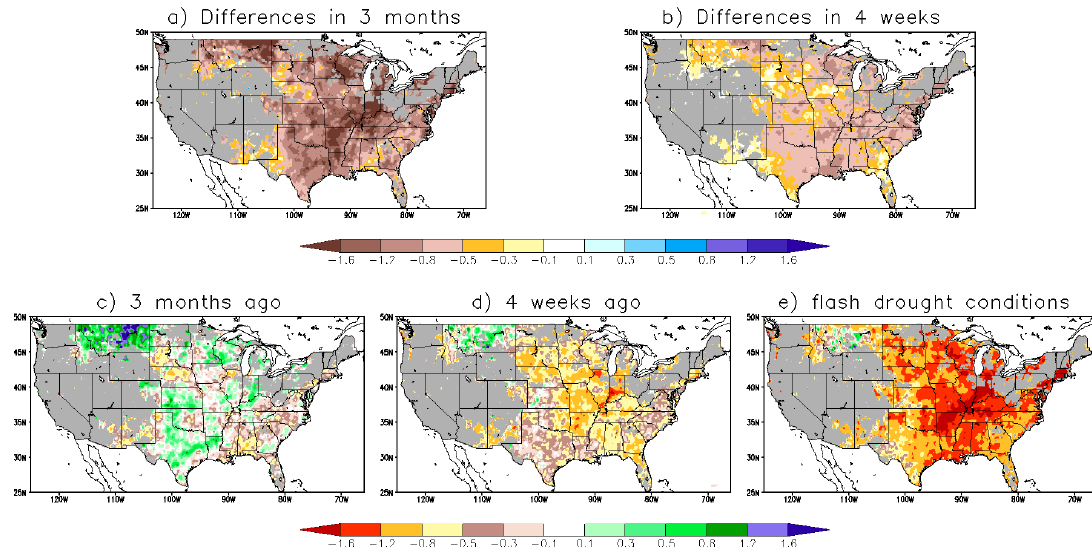
Figure 11. Composites of seven-day Standardized Soil Moisture Index for ( a ) differences between flash drought conditions and the conditions three months ago, ( b ) differences between flash drought conditions and the conditions four weeks ago, ( c ) the conditions three months before drought onset, ( d ) the conditions four weeks before drought onset, and ( e ) the conditions under flash drought onset. Areas with less than 1% flash drought occurrence are shown in grey.